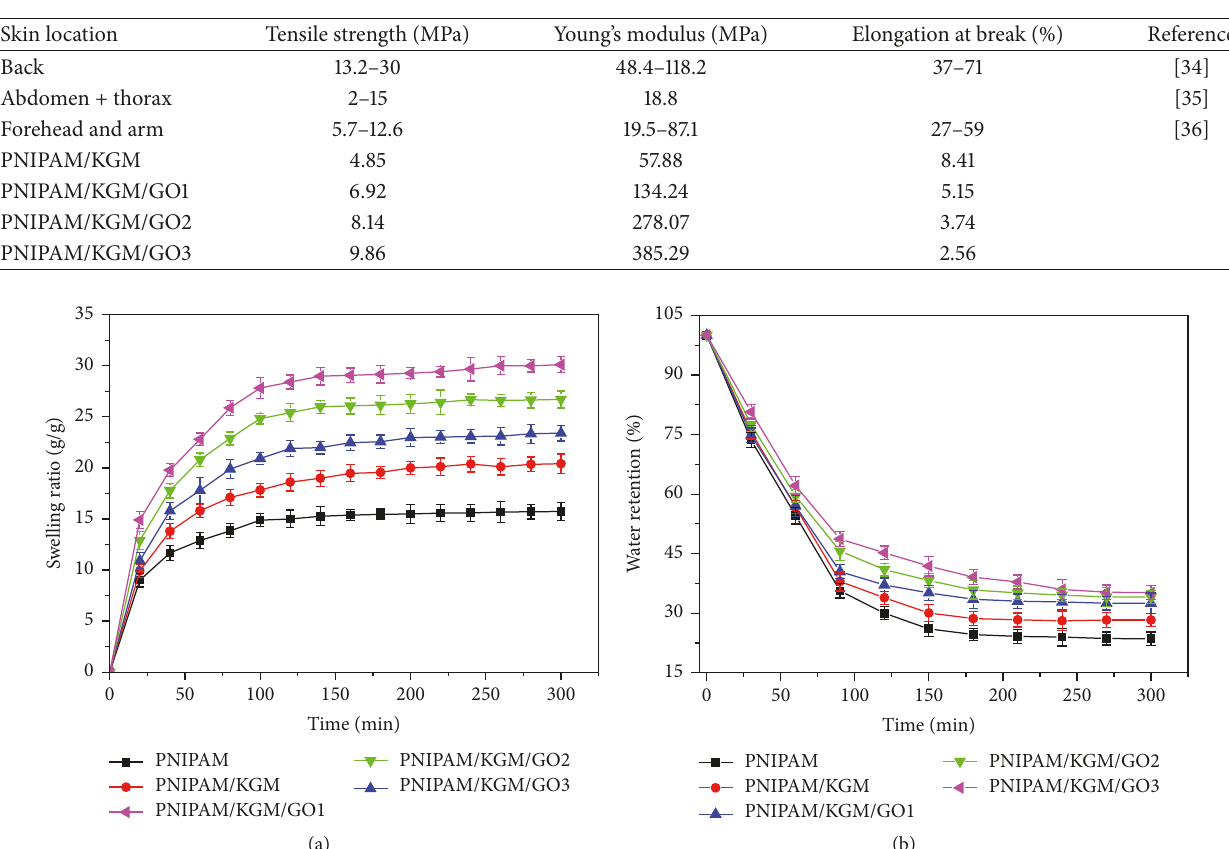
Figure 7: Swelling ratios (a) and water retention (b) of conventional PNIPAM, PNIPAM/KGM, and PNIPAM/KGM/GO composite membranes with different amounts of GO at 20 ∘ C and 50 ∘ C,